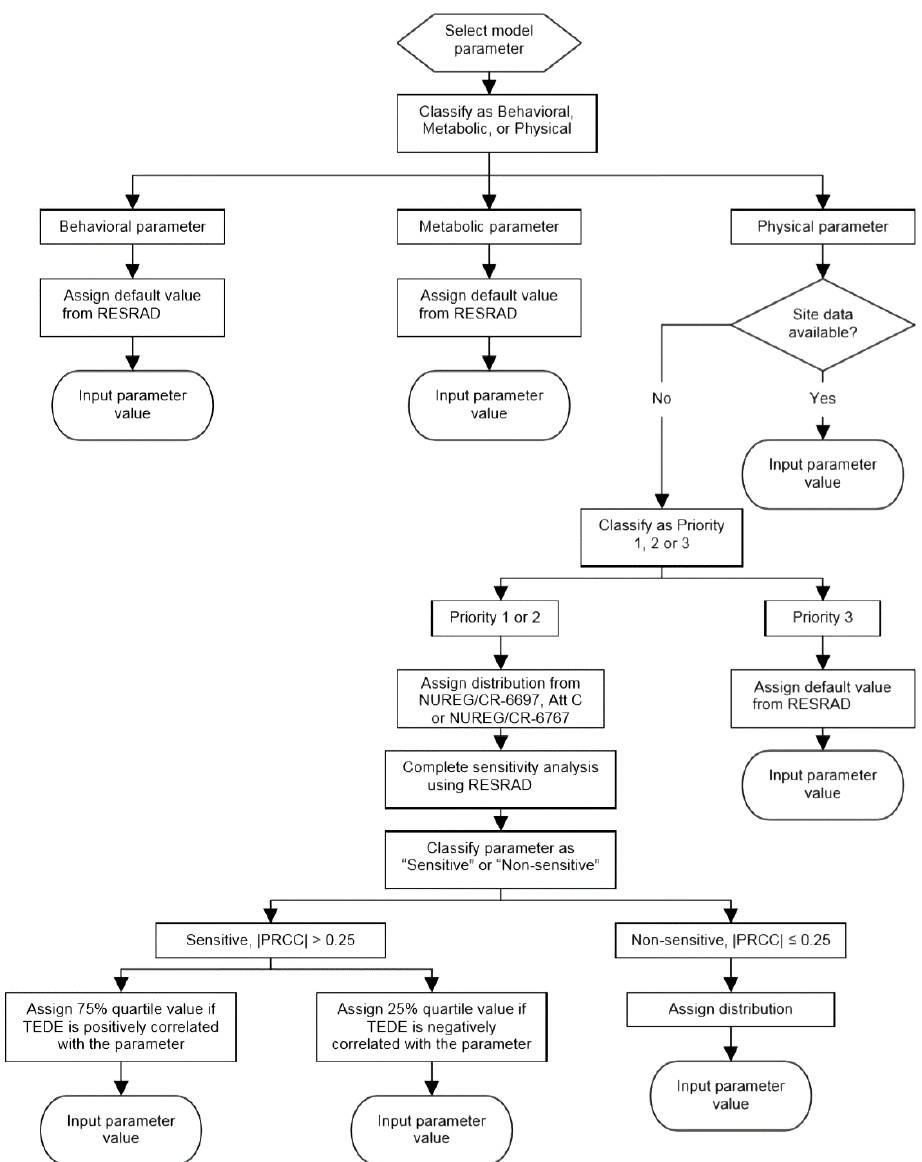
Figure 2. Sensitive parameter selection procedure.